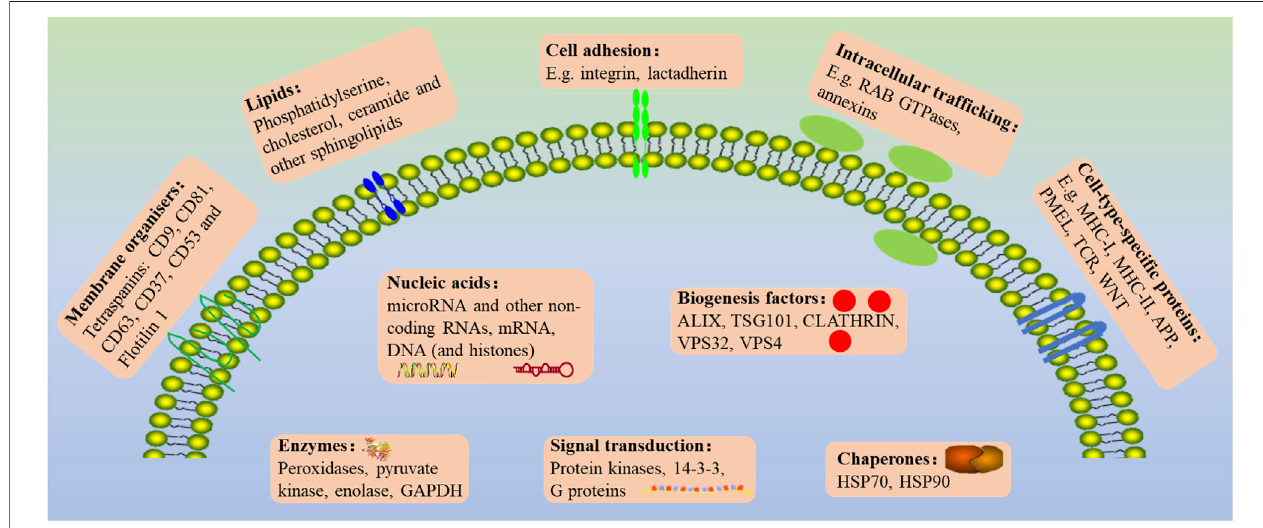
FIGURE 2 | The general outlook of the EVs membrane composition and different molecular cargoes can markedly vary based on the parental cell and vesicle biogenesis.